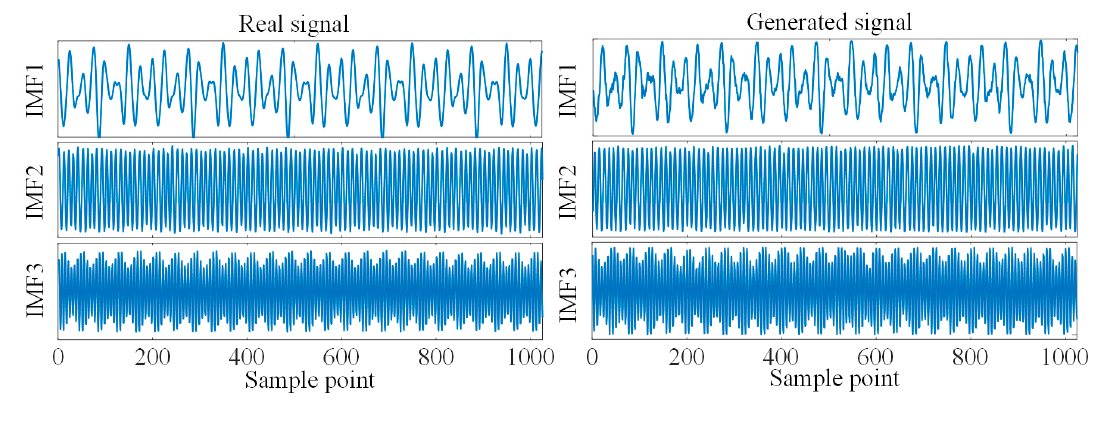
Figure 3. Effect comparison of three methods.